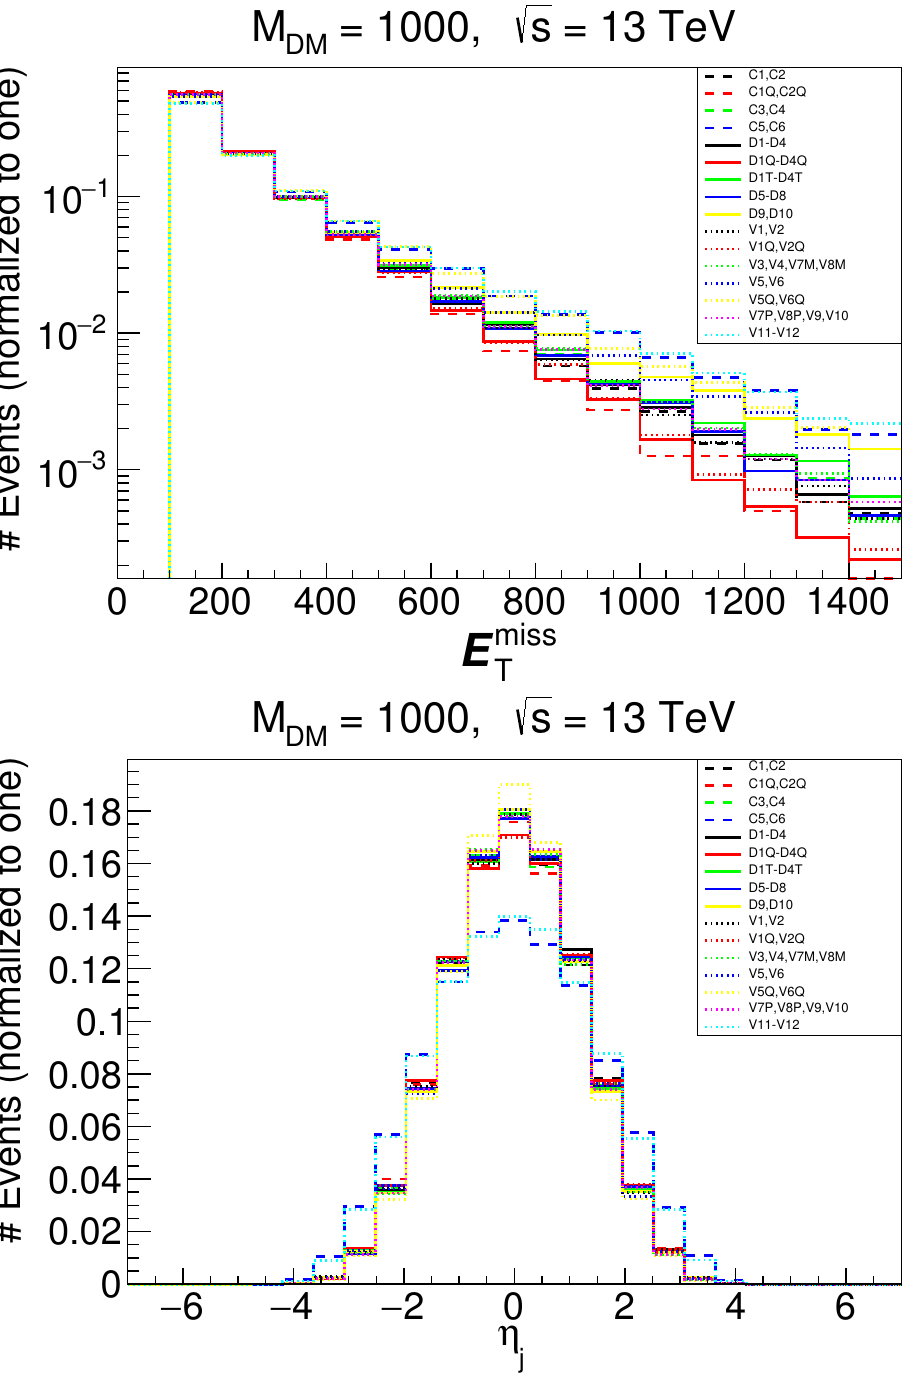
Figure 6 . E miss (top) and pseudorapidity of the mono-jet (bottom) distributions normalised to T unity for EFT operators listed in tables 1 and 2 for 13 TeV LHC energy, M DM = 1000 GeV and p T; jet (cid:21) 100 GeV cut applied.